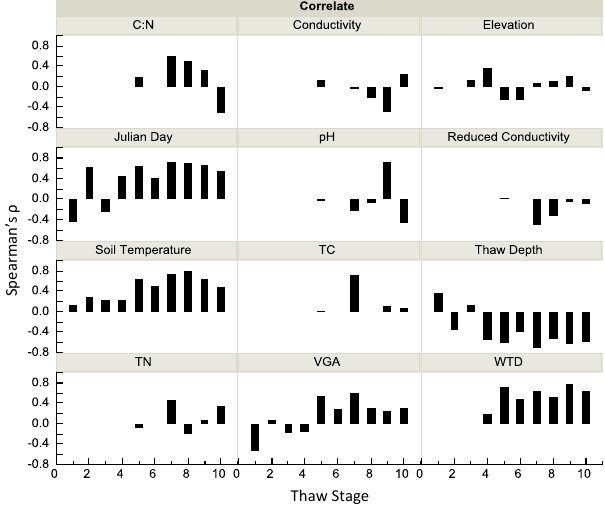
Figure 3. Correlation coefficients of CH 4 flux with biotic and abi- otic variables within thaw stages. Changing strength and directions of correlations are shown for thaw stages 1 to 10; where stage 1 is intact permafrost and stage 10 is fully thawed. Each data point represents a correlation analysis of n = 19 days. The missing data points in WTD, conductivity, reduced conductivity, pH, TC, TN and C:N (total carbon, nitrogen and C:N in surface water) are from the thaw stages that did not have a water table or had a correlation co- efficient of